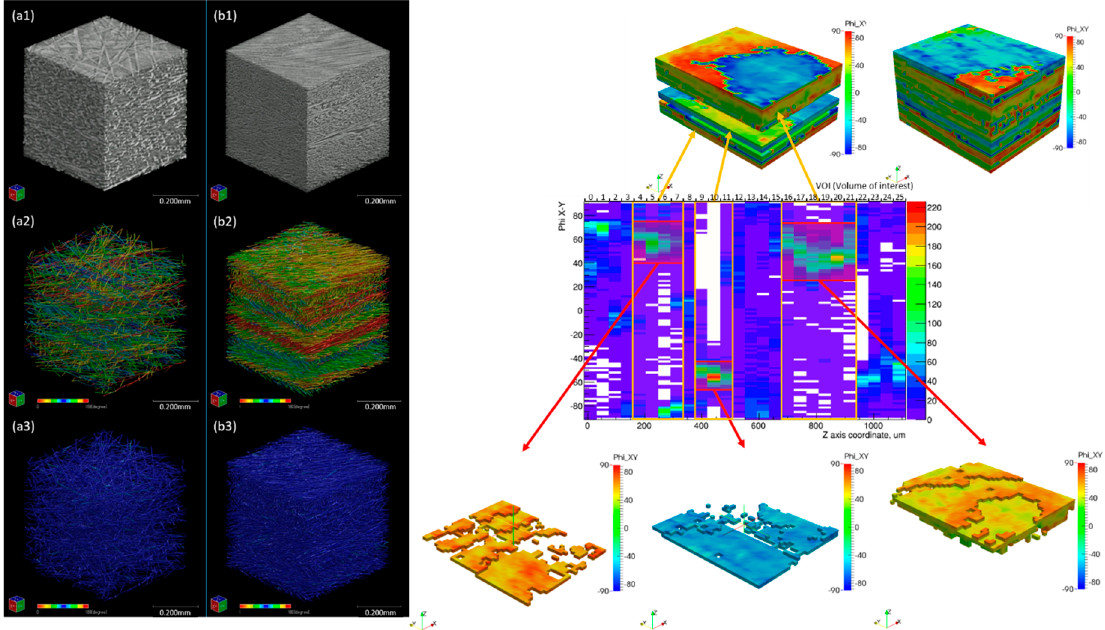
Figure 11. μ -CT methodologies for the study of the internal geometry of CTTs [33,60]. Figure 11. µ -CT methodologies for the study of the internal geometry of CTTs